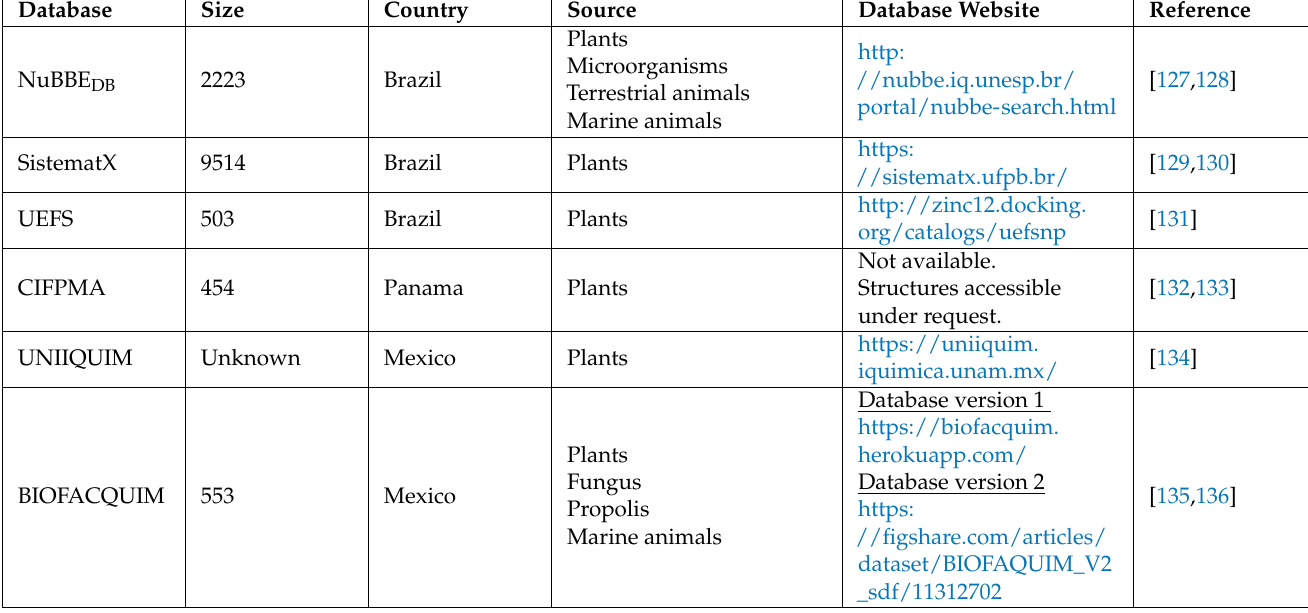
Table 3. Latin American natural products